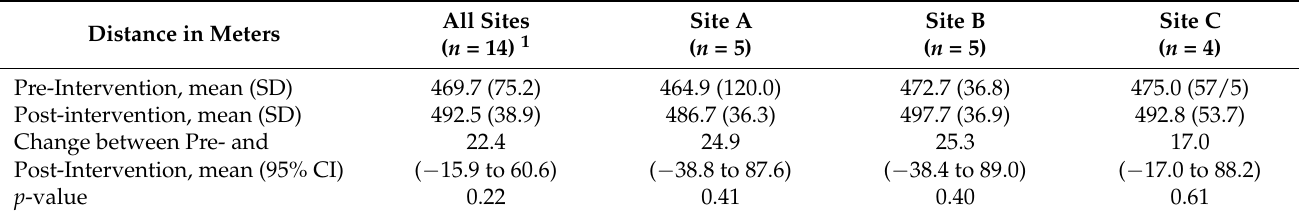
Table 2. Six-minute walk test results pre- and post-intervention.